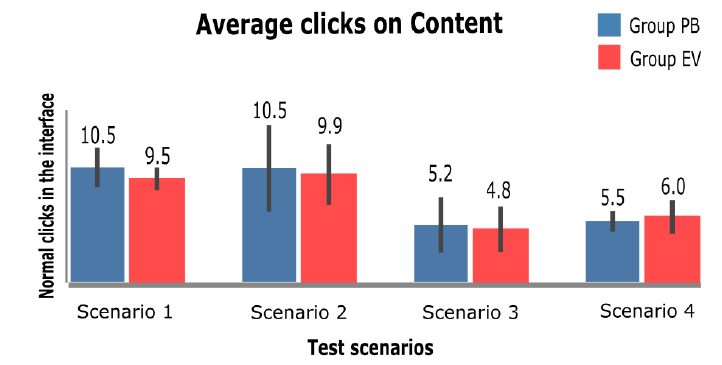
Figure 16. Average of normal clicks on the interface.